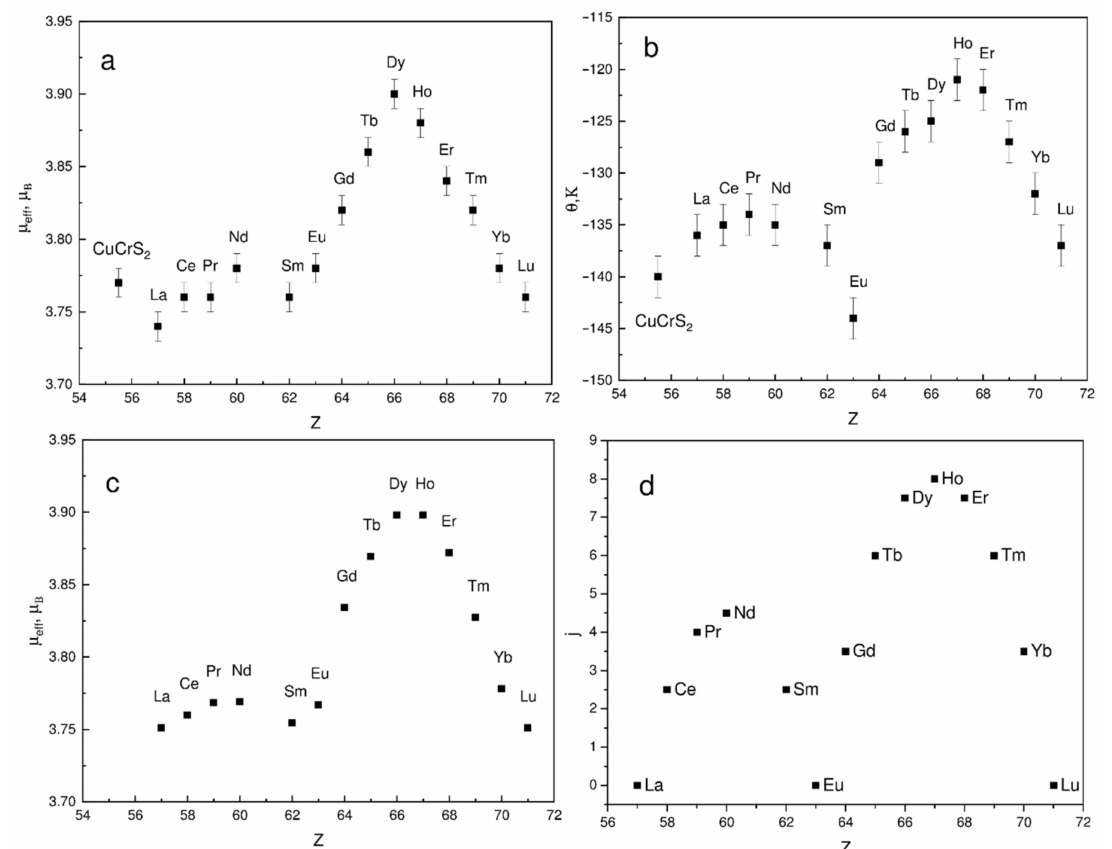
Figure 4. Experimental magnetic moment ( a ), Weiss constant ( b ), theoretical estimation of µ eff ( c ), and the total angular momentum quantum number ( d ) as a function of lanthanide atomic